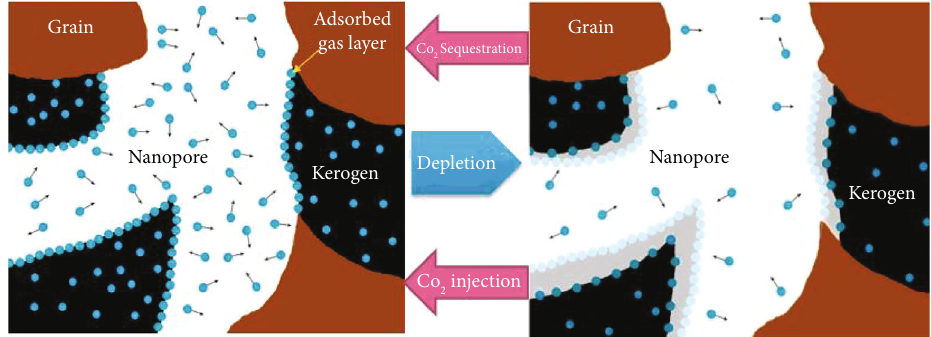
Figure 2: Gas desorption process in nanoscale. During gas production, gas molecules fi rstly desorb from the kerogen surface to the pore and then move outward due to pressure/concentration drop. Then, kerogen tends to shrink, together with the